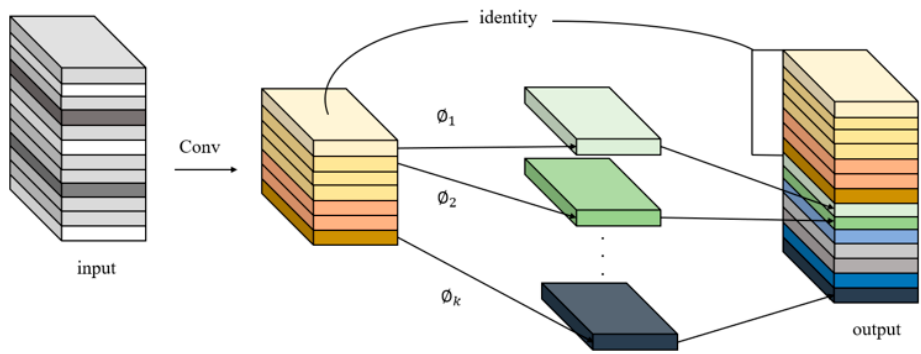
Figure 3. GhostConv structure diagram.